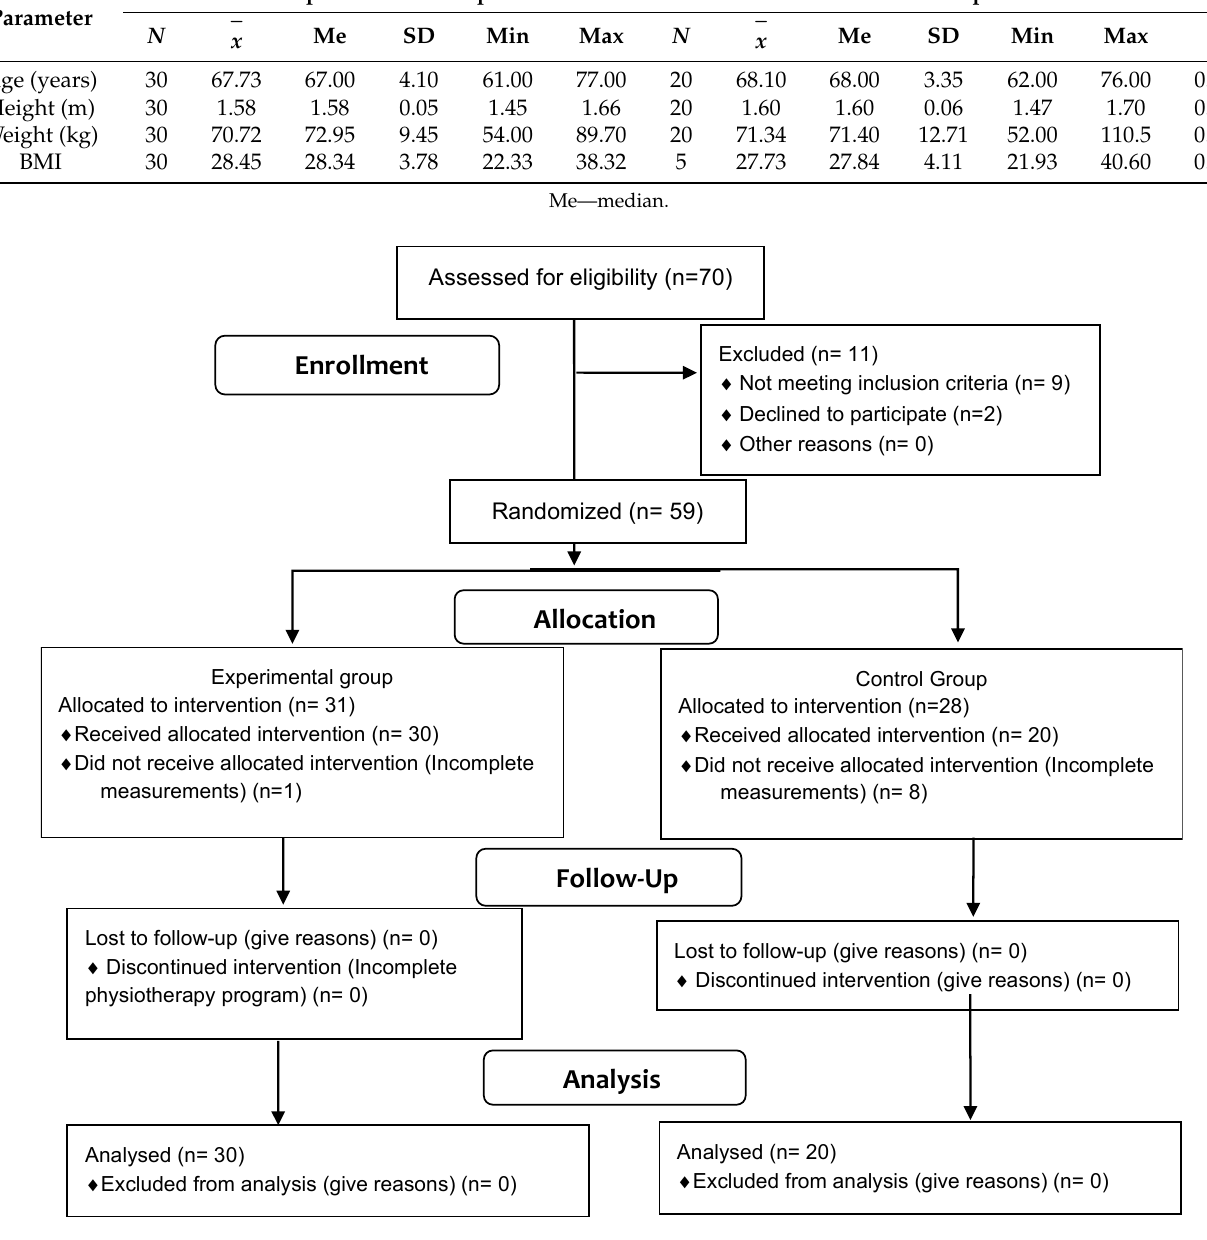
Figure 1. Consort Figure 1. Consort diagram.